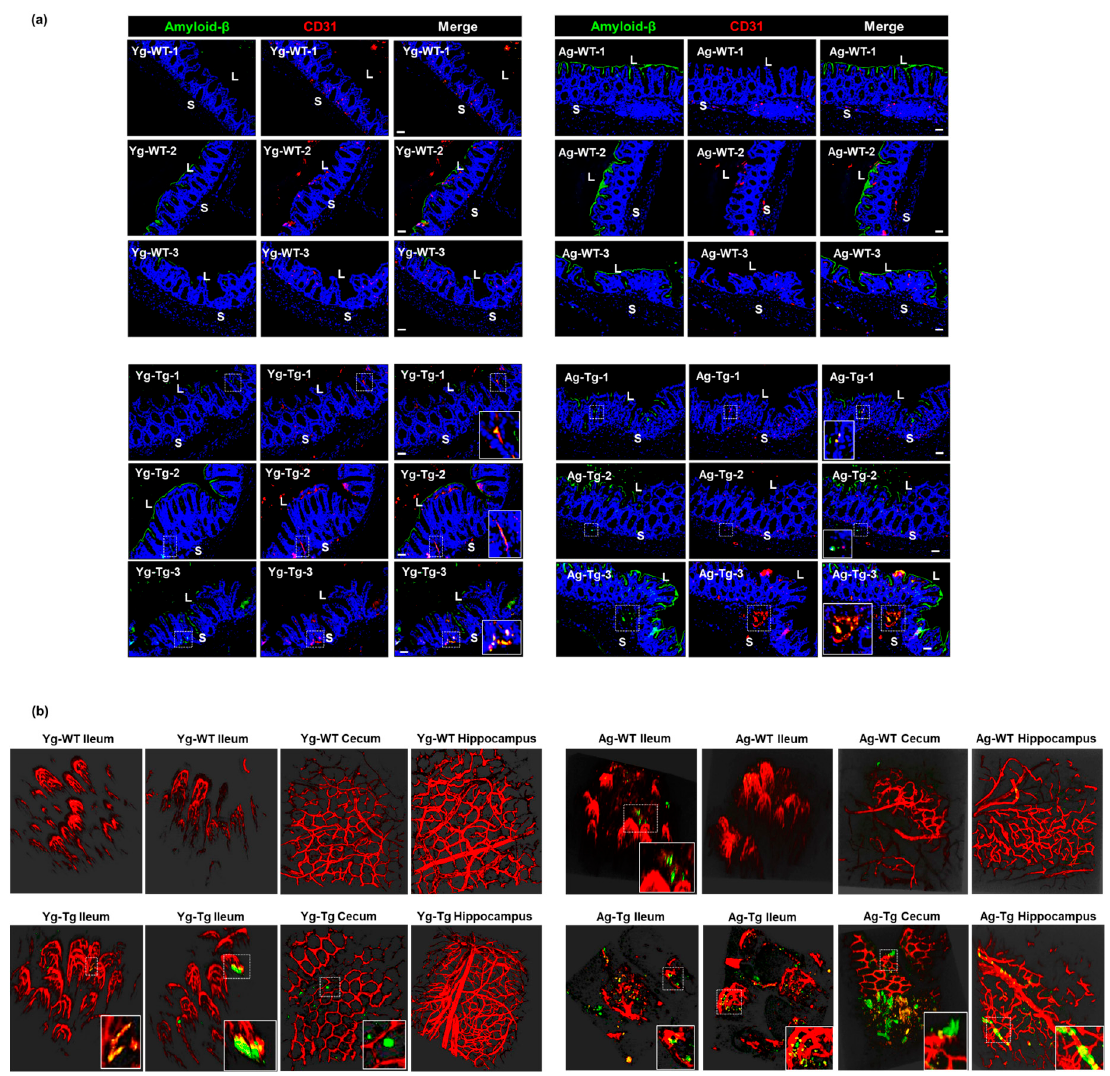
Figure 6. A β co ‐ localization with the intestinal vasculature in pre ‐ symptomatic Tg2576 (Yg ‐ Tg). ( a ) Immunohistochemical staining of A β by 4G8 antibody shows detectible A β deposits co ‐ localized with vascular CD31 in the intestinal samples from Tg2576 at pre ‐ symptomatic timepoint of 6 months (Yg ‐ Tg) compared to age ‐ matched WT littermate controls (Yg ‐ WT) which significantly intensifies by 15 months (Ag ‐ Tg). ( b ) Two ‐ photon imaging of intestinal tissue shows detectible levels of A β accumulation with ileal and cecal vasculature in the gut but not in the hippocampus of the brain at 6 months in Tg2576 mice (Yg ‐ Tg). Ileum, cecum and hippocampus samples show strong A β plaques co ‐ localized with intestinal and cerebral vasculature at 15 months in Tg2576 mice (Ag ‐ Tg). Data are obtained from >two independent experiments per group at various times ( a ) and separate set of two independent experiments at different times ( b ) due to dye injection. ( a ) Magnification 20×. Bar indicates 50 μ m. L—luminal, S—serosal, Yg—young, Ag—aged, Tg—transgenic, WT—wild type. Red—CD31, Green—amyloid β , Blue—DAPI nuclei. (b) Red—vasculature, Green—amyloid β . ( b ) Magnification 20×.